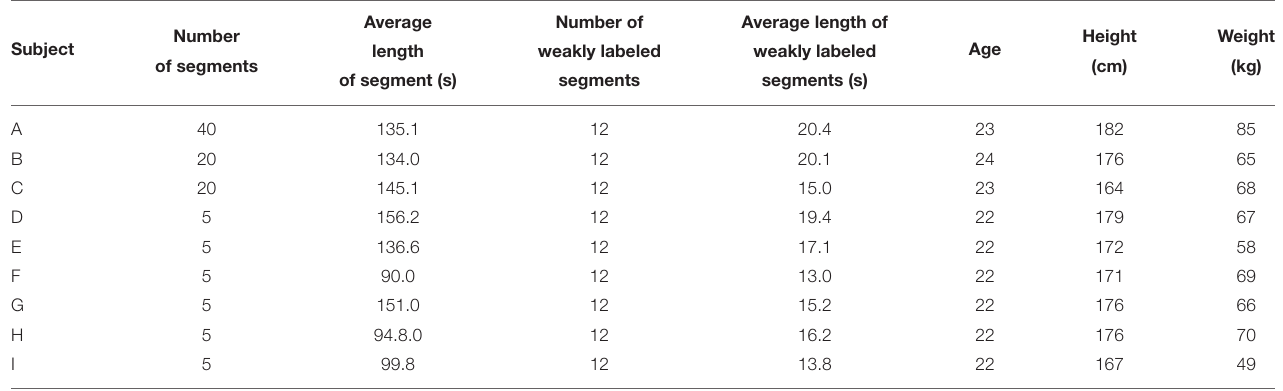
TABLE 2 | Overview of dataset.